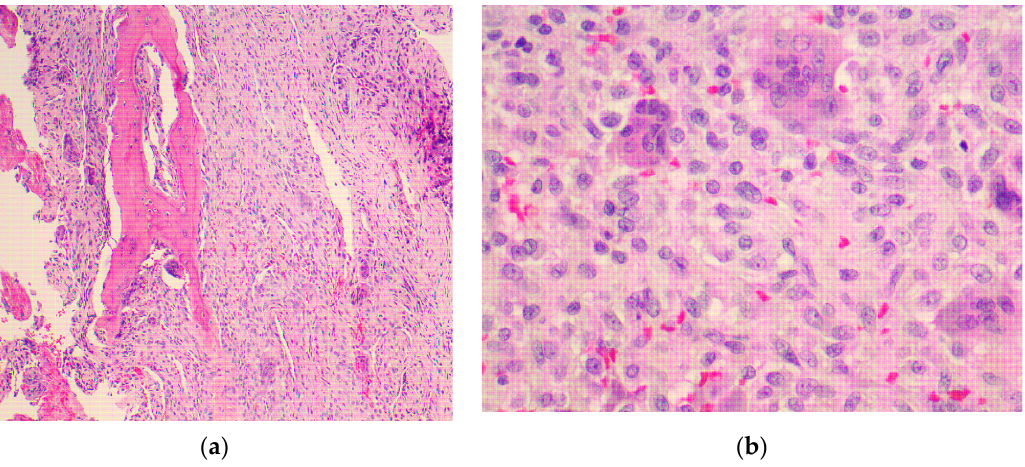
Figure 4. ( a ) Low magnification histologic examination of GCT of L5 vertebral body shows residual bone trabeculae with focal osteoid production. ( b ) High magnification histologic examination of a GCT of L5 vertebral body shows mononuclear cells interspersed with multinucleated giant cells.